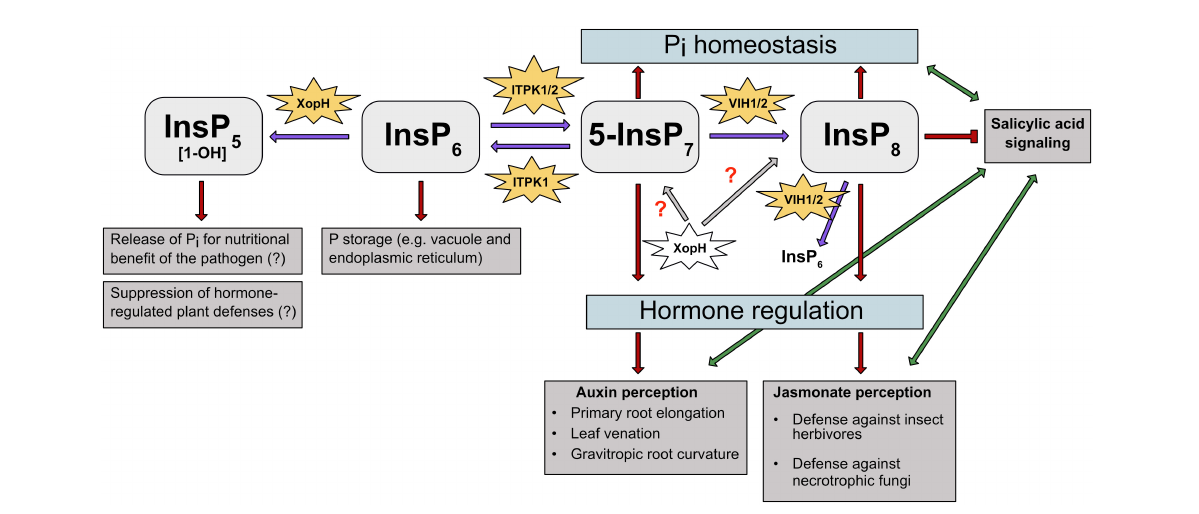
FIGURE3 PP-InsPs and their kinases are involved in different abiotic and biotic stress responses in plants. PP-InsPs’ involvement in Pi homeostasis, hormone perception and regulation is depicted. Purple arrows indicate the kinase/phosphatase activity of the respective enzymes on InsPs and PP-InsPs. Gray arrows and red question marks depict a putative effect of XopH on PP-InsPs. Red arrows and T-shaped line indicate promotion and suppression of specific InsPs and PP-InsPs in regulating stress responses, respectively. Green arrows depict the interplay between plant hormones auxin, JA and SA, respectively. ITPK1 phosphorylates InsP6 to 5-InsP7. The latter serves as precursor for InsP8, which plays a crucial role in adaption to changing Pi levels. Additionally, InsP6 is degraded by XopH to potentially release Pi for the pathogen’s nutritional benefit. ITPK1 and VIH2 interaction is needed to maintain Pi homeostasis. Higher PP-InsPs are also involved in hormone perception and regulation. The ITPK1-generated 5-InsP7 is speculated to be involved in auxin and SA signaling. The VIH2- generated InsP8 has been proposed to represent